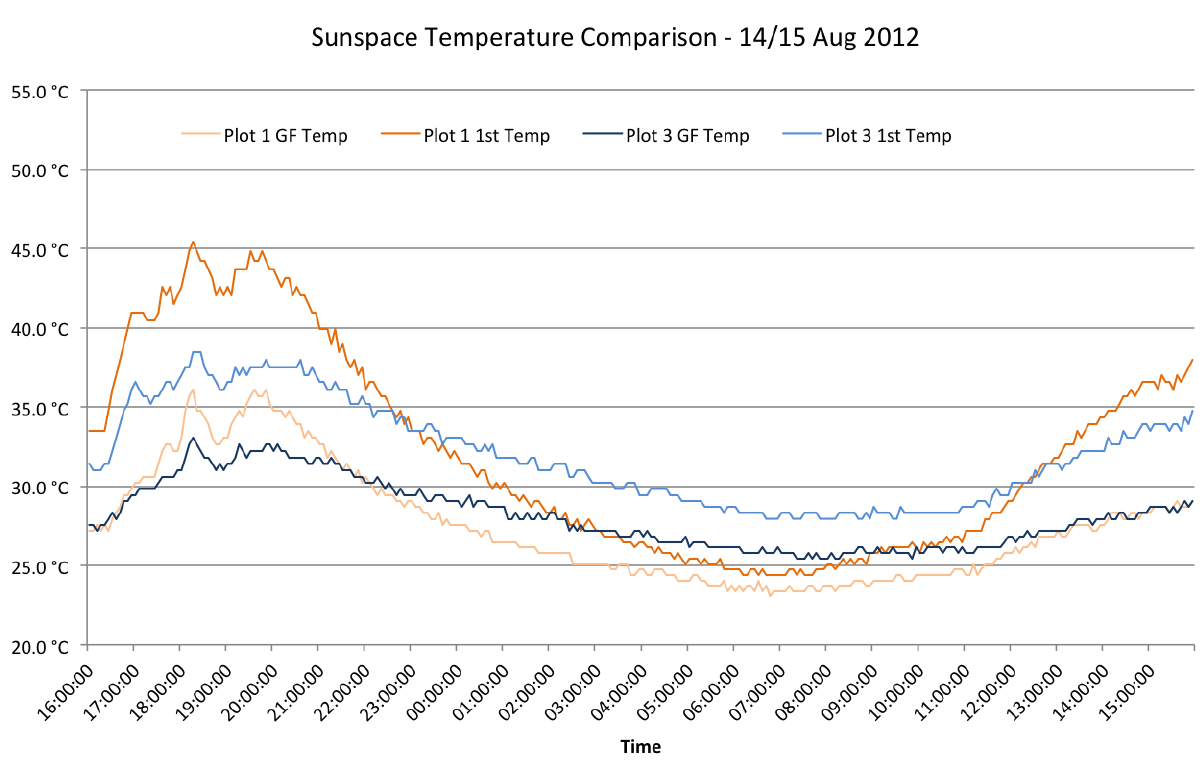
Figure 13. SC4 sunspace temperatures ground floor/first floor Plot 1; ground floor/first floor Plot